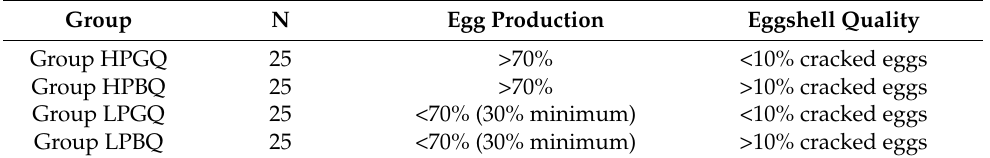
Table 1. Experimental groups of laying hens with different egg production and egg